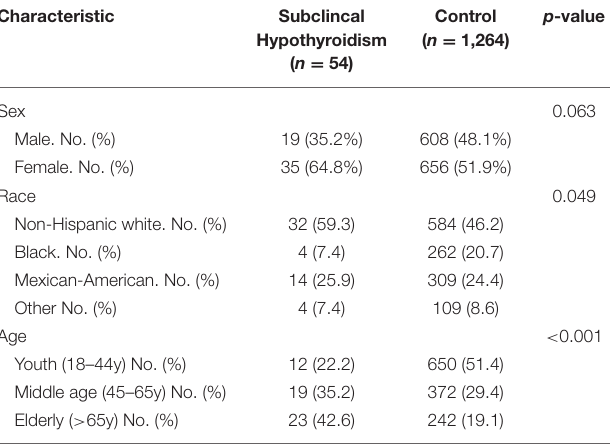
TABLE 1 | Demographics of the sample population.